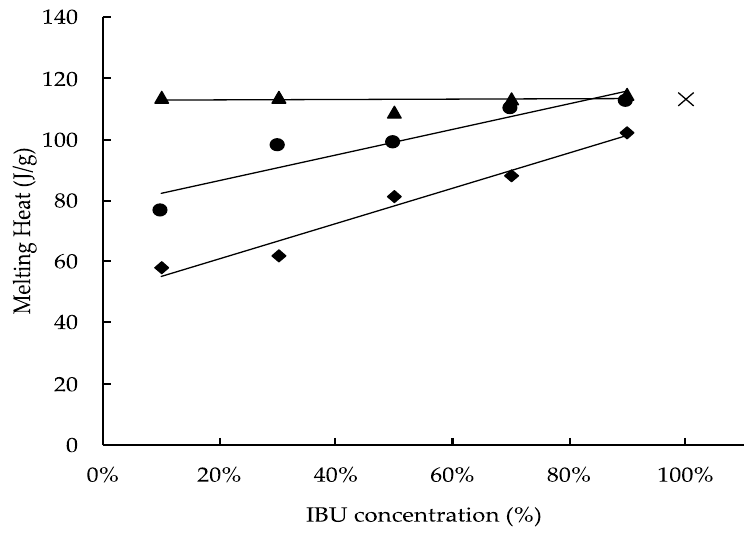
Figure 4. The enthalpy of fusion of IBU in various samples. ×: IBU crystals; ◆ : PS300-PMs; ● : CaSiO 3 -PMs; ▲ : ZrO 2 Beads-PMs.